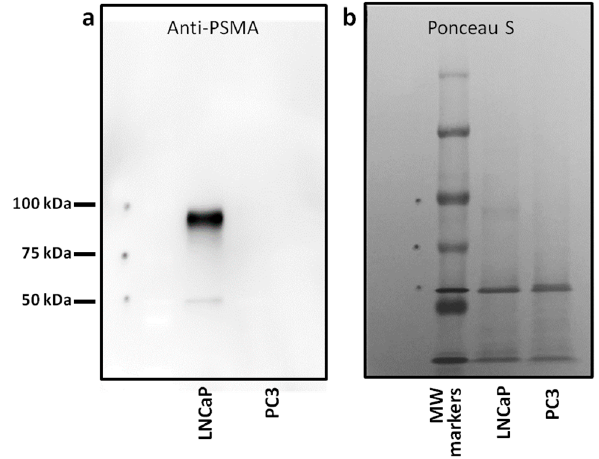
Figure 1. Western blots of prostate specific membrane antigen (PSMA) protein in membrane fractions isolated from LNCaP and PC3 cells. ( a ) Membrane fractions were immunoblotted using anti-PSMA antibody. ( b ) The same membrane was stained with Ponceau S stain.